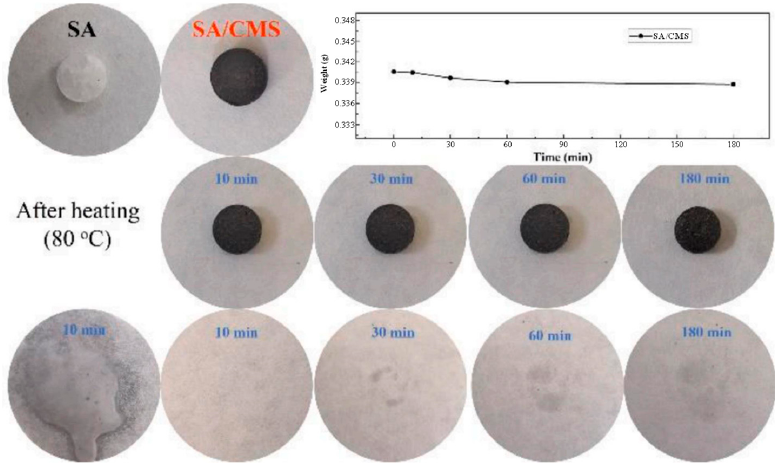
Figure 4. Leakage trace of SA and form and weight changes after different heating times [56].